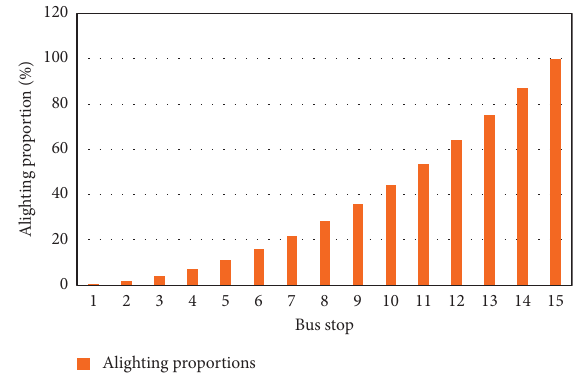
Figure 4: Percentage of average passenger alighting at each